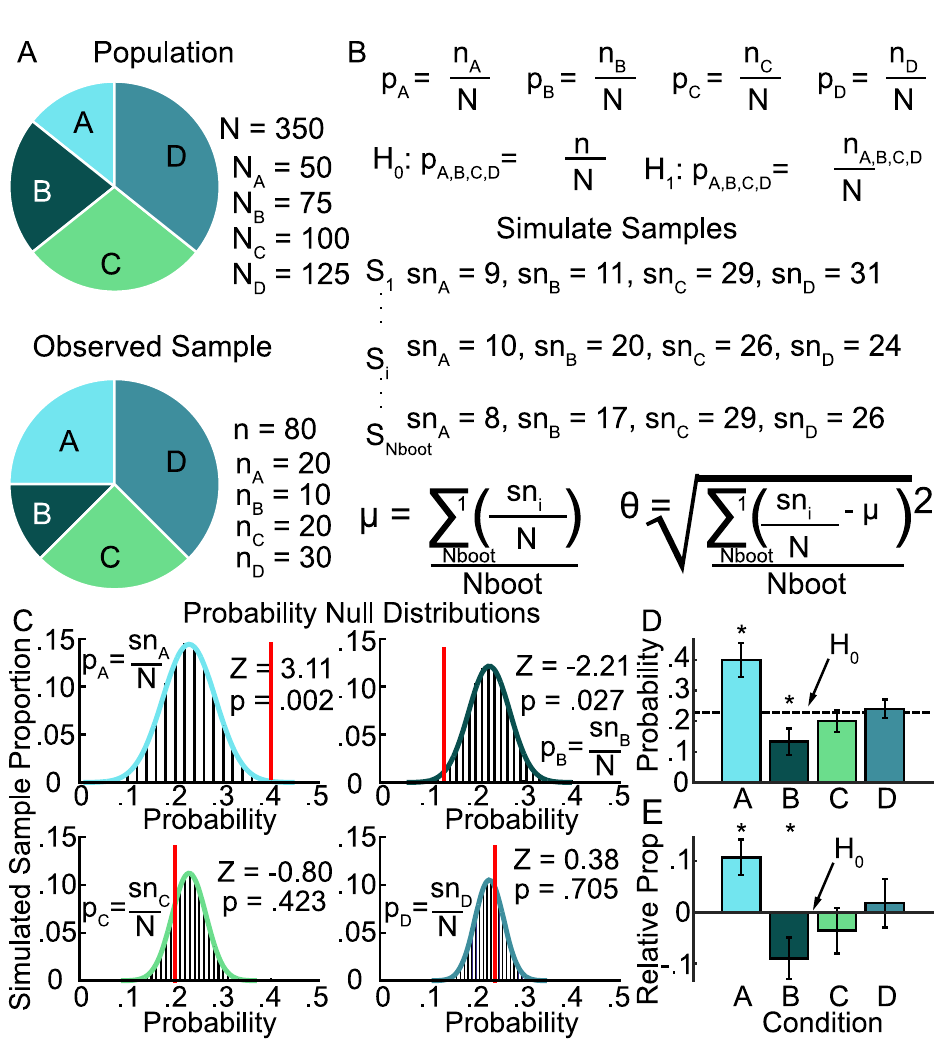
Fig 3. Example of simulated null distribution permutation test for probability analysis. A, Example of hypothetical population, size N, consisting of 4 members and yielding observed sample, size n, consisting of the 4 members. The question to address: Is there category-specific variation in the probability of occurrence for different members of the observed samples? B , Equations demonstrating how to represent the question in A as a null hypothesis, and how to simulate samples from the population. C , Distributions (histograms) and fitted normal distributions (curves) showing the proportion of simulations yielding a given probability of member occurrence under the null hypothesis. Red lines indicate where the observed sample falls relative to the null distribution, with matching Z statistic and p-value before correction. D , Category-specific probability of occurrence where error bars indicate ± 1SD of the null distribution. � indicates statistical significance. E , Similar figure to ( D ), but representing the relative proportion of sample occurrences and the null hypothesis that the member proportions observed are the same as those observed in the